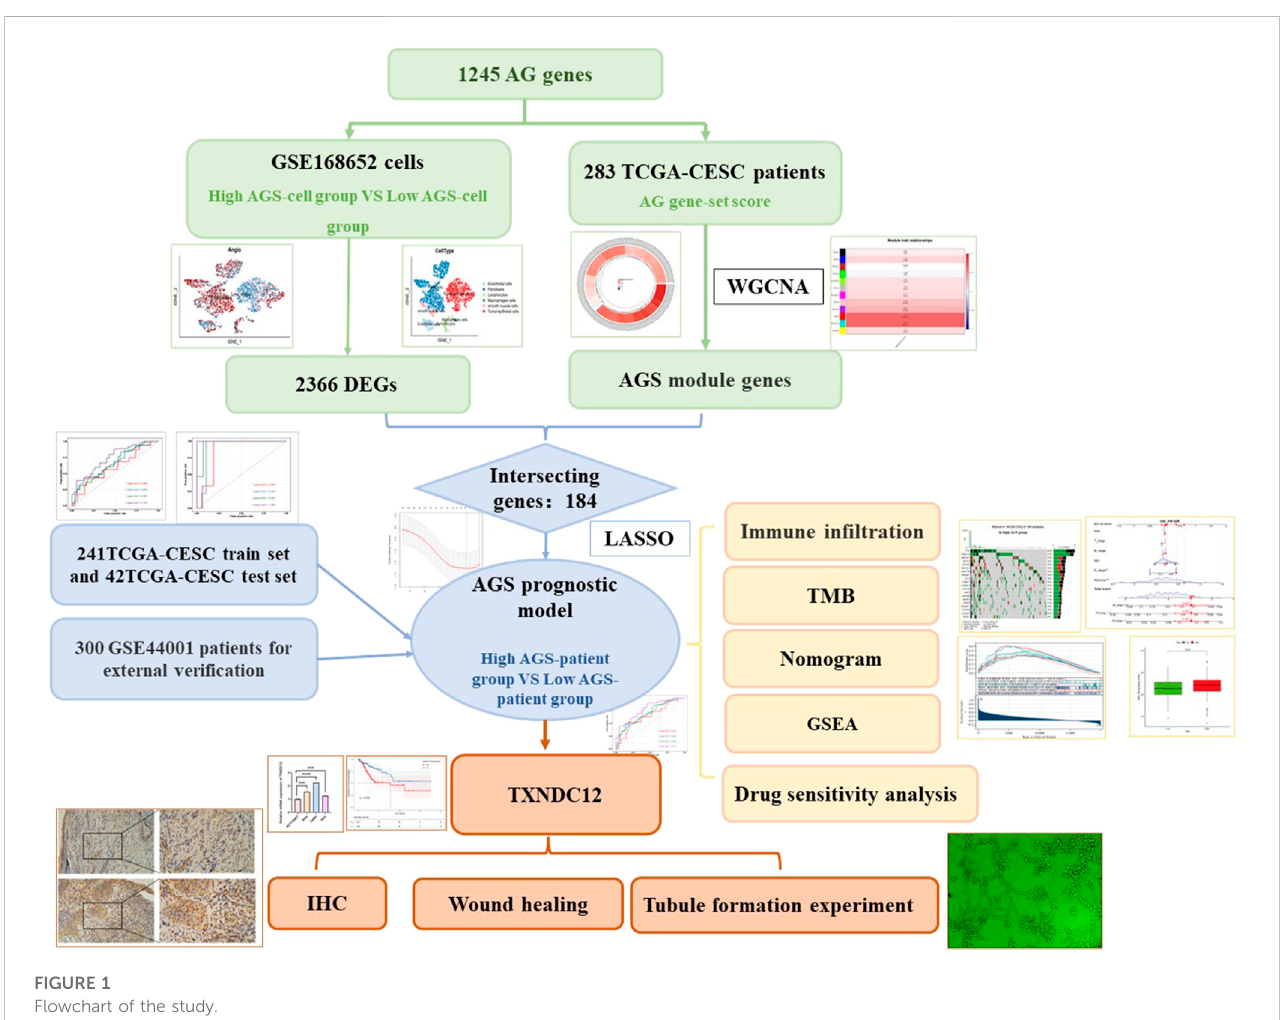
FIGURE 1 Flowchart of the